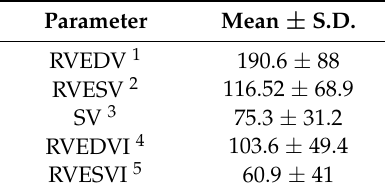
Table 1. Parameters related to right ventricular dilatation measured by